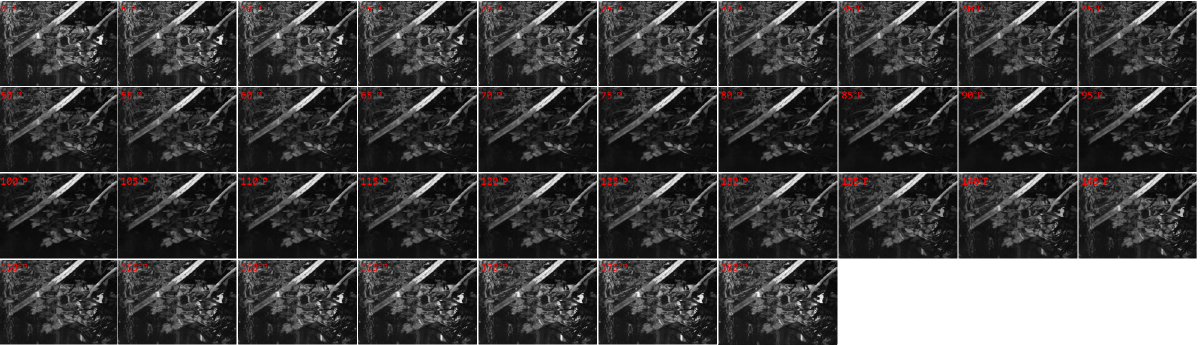
Figure 6. Simulated directional polarization images for case